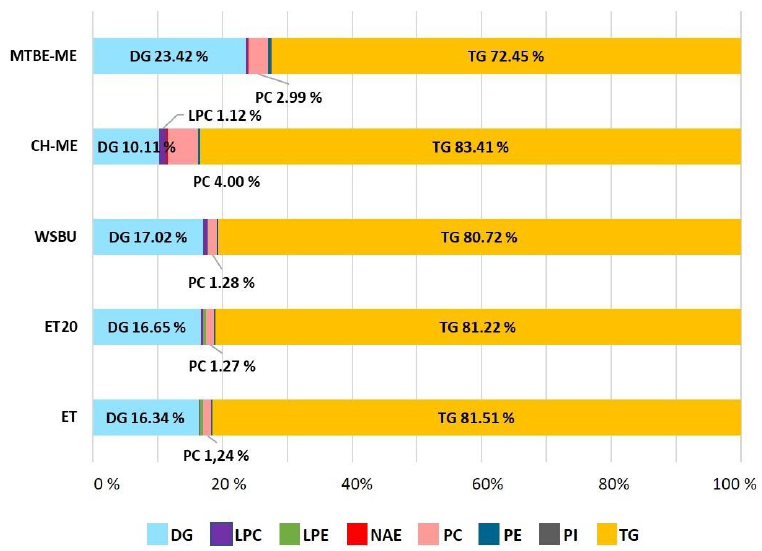
Figure 4. Content (%) of lipids distributed in different classes present in lipid extracts obtained with different extraction methods from rice bran (lipid classes with content < 1.00% are not shown).